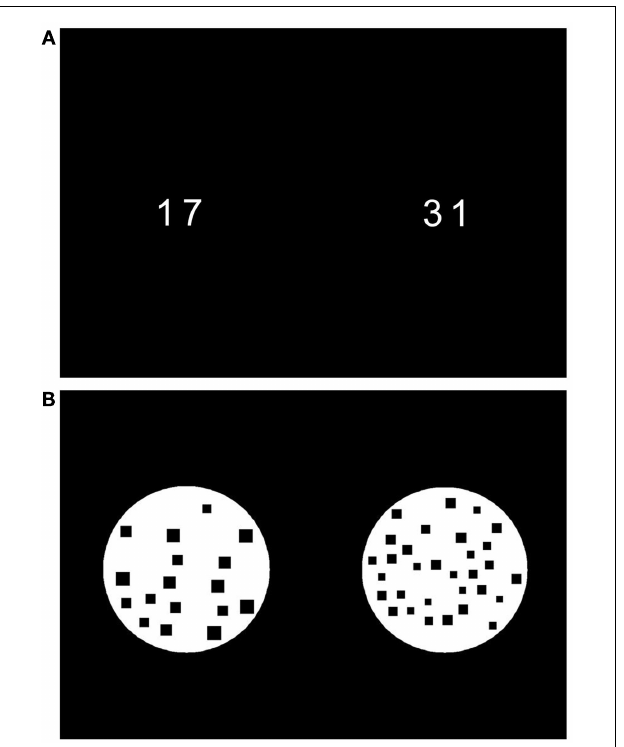
FIGURE 1 | Schematic illustration of two example stimuli. (A) depicts a symbolic-digital pair of to be compared numbers, whereas (B) reflects the corresponding pair of non-symbolic quantities. Participants had to indicate the larger